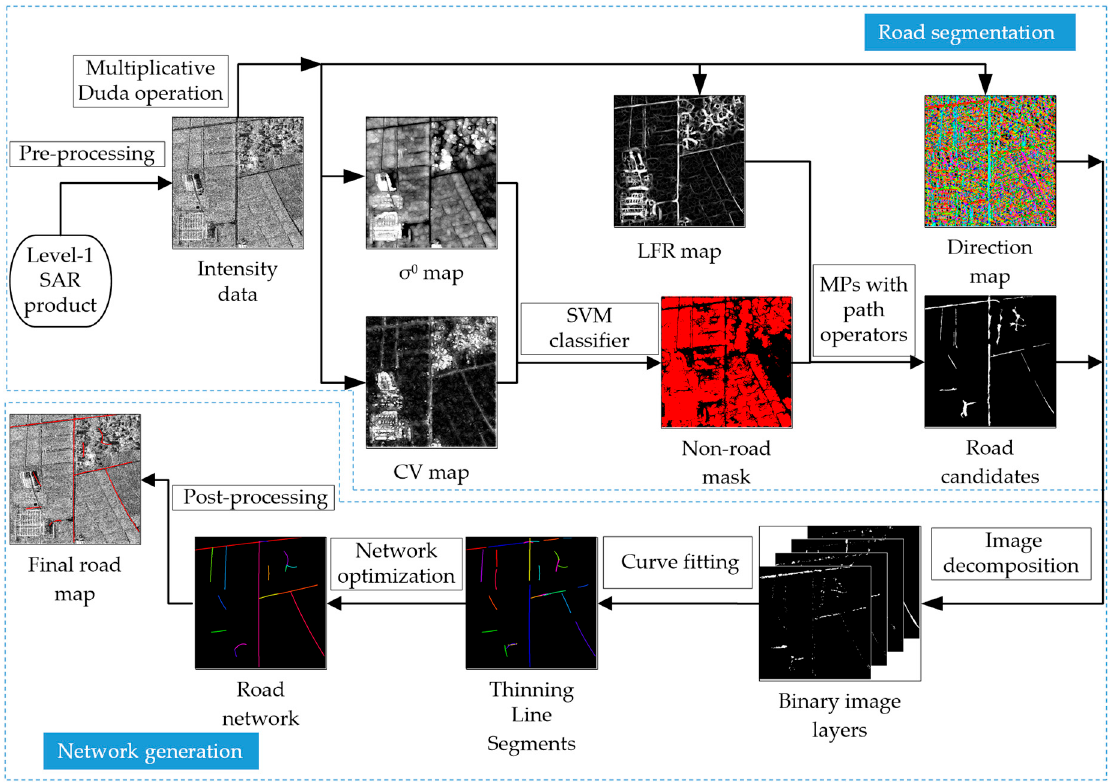
Figure 1. Flowchart of the proposed method.